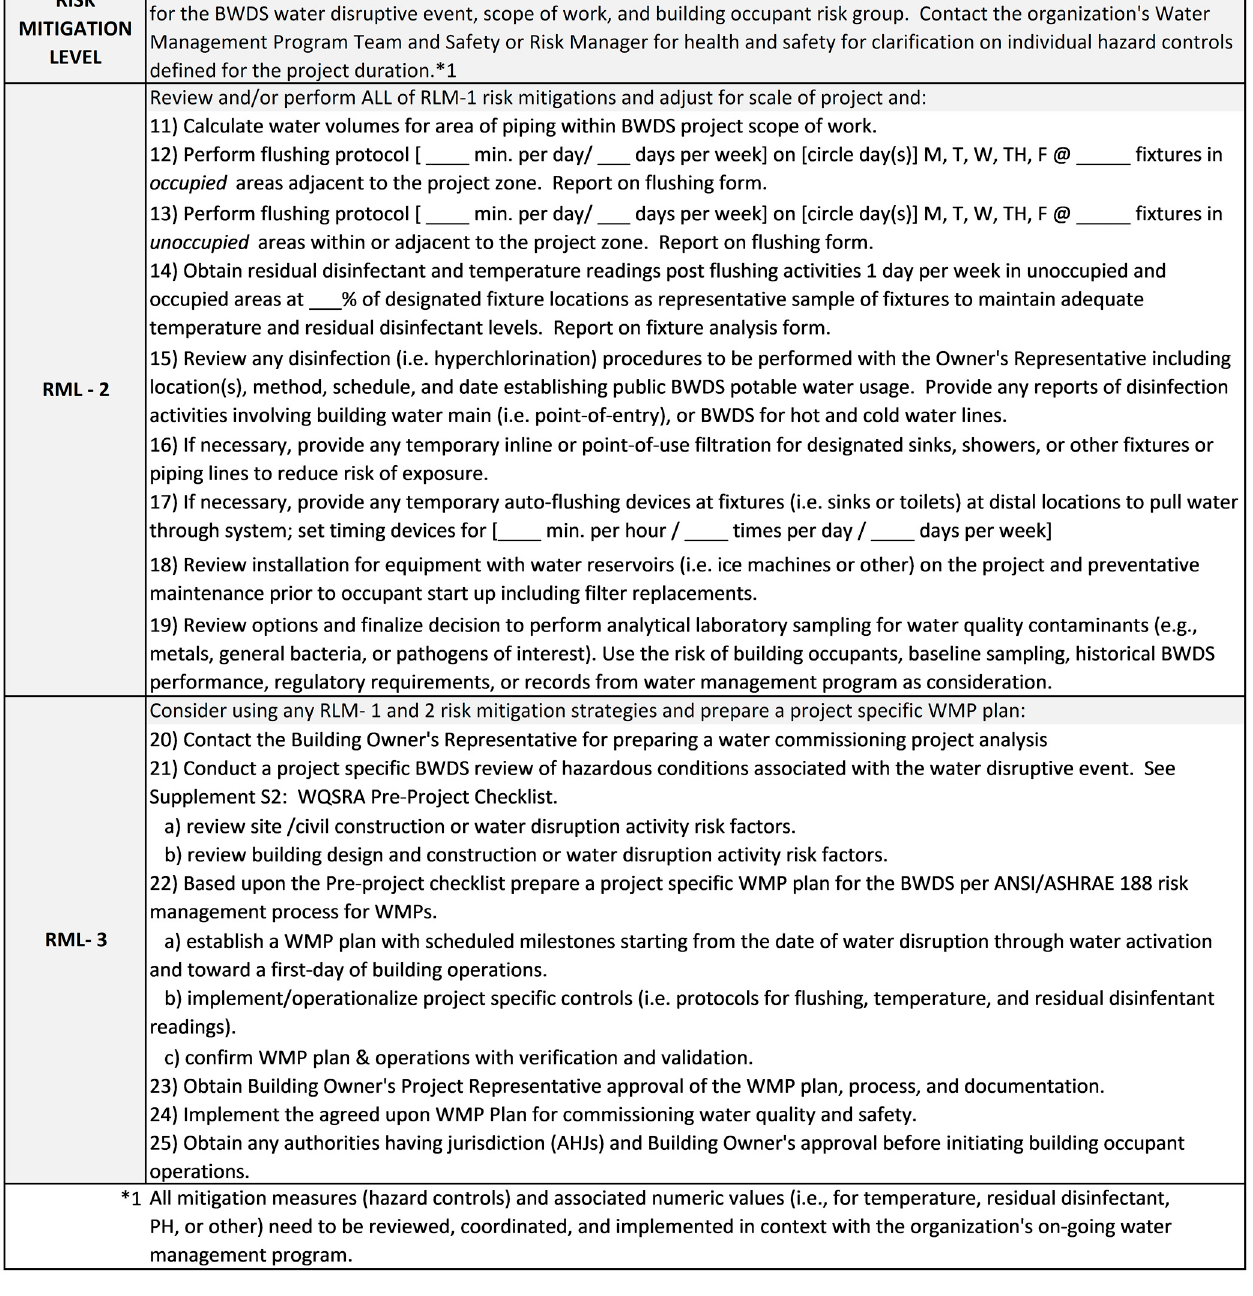
Figure 7. WQSRA risk mitigation levels 2 and 3. Adapted with permission from Ref. [50]. 2022, Scanlon et al. (CC BY 4.0).